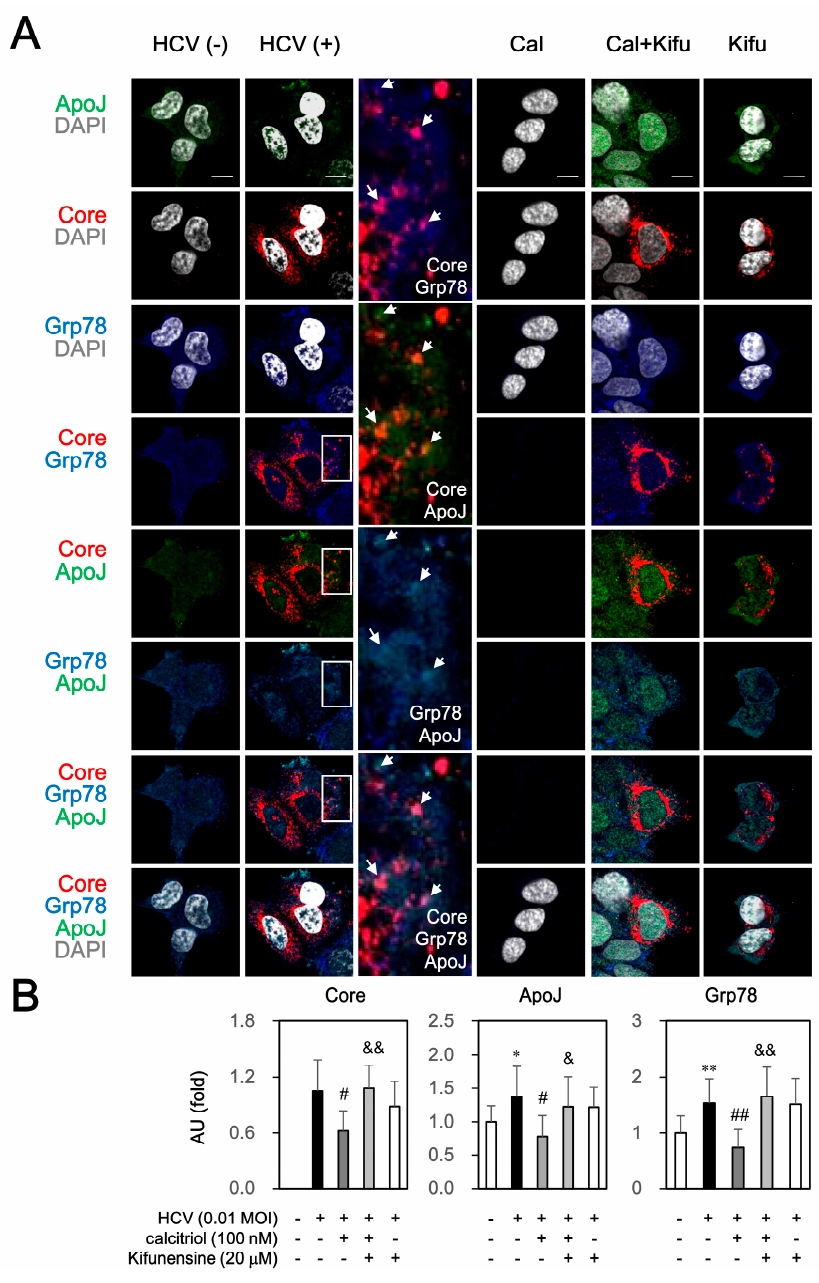
Figure 7. Effect of ERAD inhibitor on calcitriol-mediated protein expressions of core, Grp78 and apoJ under HCV infection. ( A ) HCV-infected Huh7.5-SEAP cells (1.5 × 10 4 ) were treated with 20 μ M of kifunensine (Kifu) for 1 h ahead of treatments with 100 nM of calcitriol (Cal) for 6 days in a 24-well plate, fixed with 1% paraformaldehyde, stained with the core, Grp78 and apoJ antibodies and counterstained with DAPI. After staining, these cells were mounted on glass slides and observed under confocal laser scanning microscope. White arrow referred to the core protein surrounded by apoJ, co-localization of core and Grp78, or co-localization of apoJ and Grp78. Scale bar, 10 μ M; ( B ) The arbitrary units (AU) of immunofluorescence intensity of the core, Grp78 and apoJ were assessed using Image J. Data are expressed as mean ± SD obtained from three independent experiments. * p < 0.05 and ** p < 0.01 vs. the medium control cells without HCV. # p < 0.05 and ## p < 0.01 vs. the HCV-infected Huh7.5-SEAP group. & p < 0.05 and && p < 0.01 vs. the calcitriol-treated group. The symbol (–) referred to the cells without HCV infection; the symbol (+) referred to the cells with HCV infection; the symbol (++) referred to the cells with HCV infection and co-treated with drug (e.g., calcitriol or kifunensine); the symbol (+++) referred to the HCV-infected cells pre-incubated with kifunensine before calcitriol treatment.